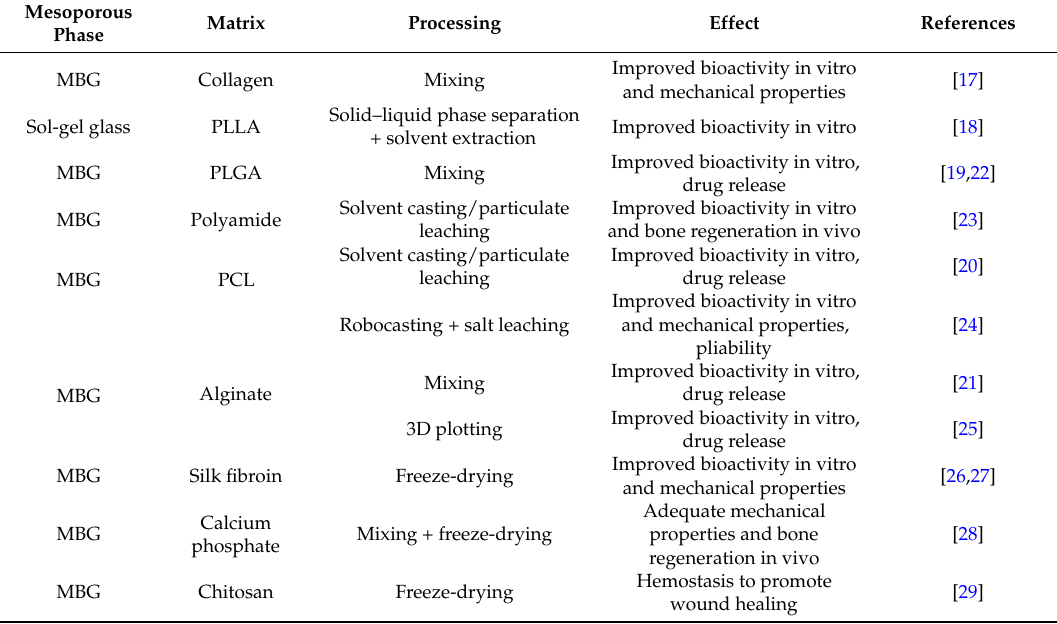
Table 1. Hierarchical composites containing a mesoporous glass